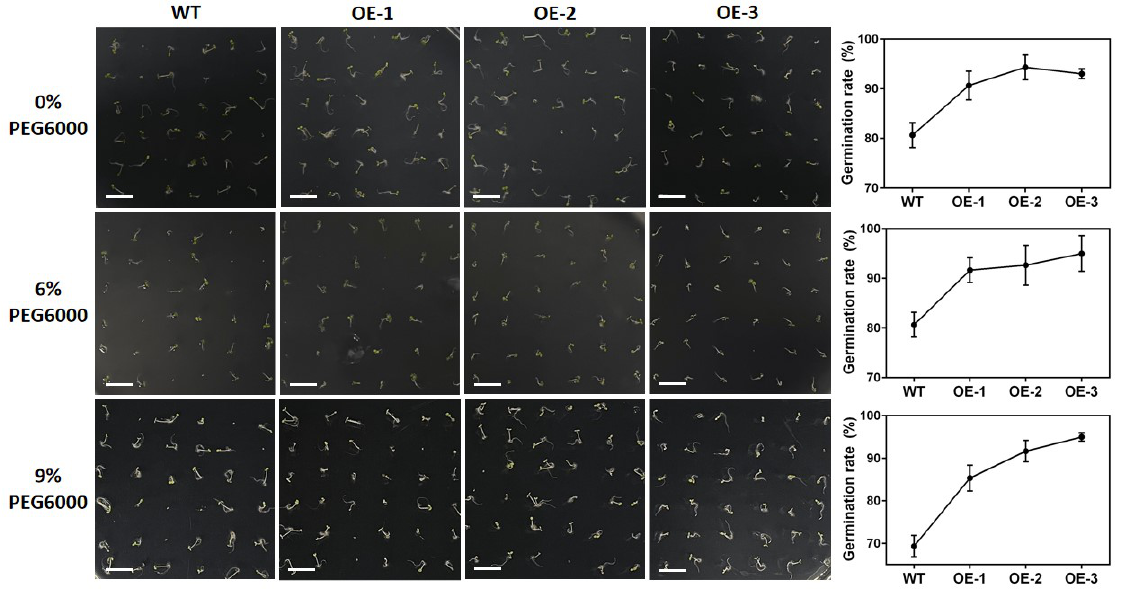
Figure 11. Germination rates of three lines of transgenic Arabidopsis thaliana with overexpression of GmNAC3 (OE-1, OE-2, and OE-3) treated with PEG6000 of three concentrations (i.e., 0%, 6%, and 9%), respectively. Bar = 1 cm.